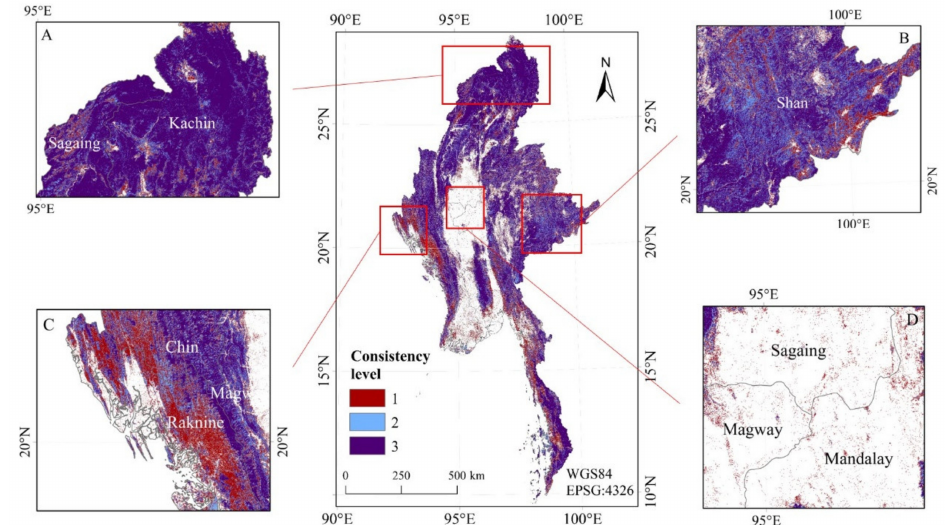
Figure 7. Spatial consistency of three datasets in 2015. Full agreement corresponds to a value of 3 (all three datasets agree), and full disagreement corresponds to a value of 1 (only one dataset identifies forest). White corresponds to no forest for all datasets. Sub-area ( A – D ), respectively, are the details of the consistency distribution for four major regions (( A ) is the area of the best consistency, ( B ) is the area of good consistency, ( C ) is the area of poor consistency, ( D ) is the area with “salt and